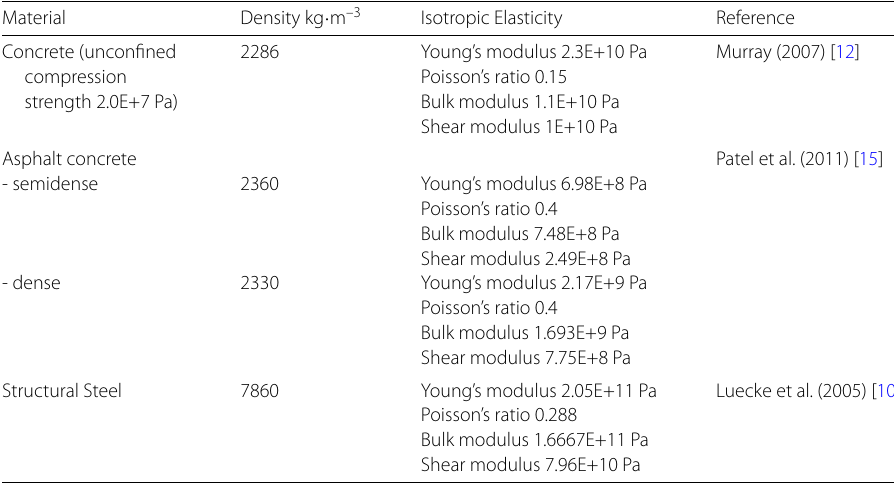
Table 1 Model parameters. Properties of materials at temperature 22 ° C